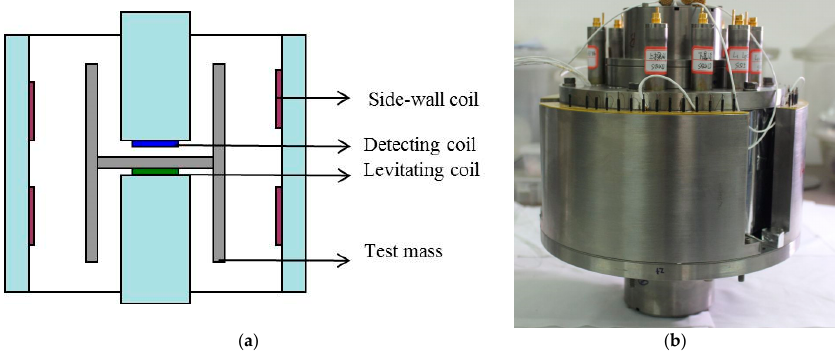
Figure 4. ( a ) Cross sectional illustration showing the layout of different types of coils; ( b ) the assembled superconducting gravity gradiometer (SGG) sensor.